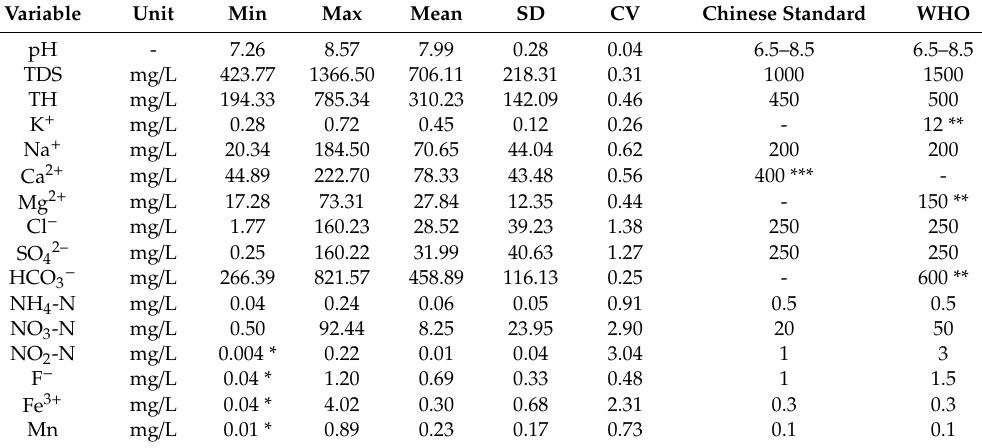
Table 2. Statistical analysis of the physicochemical parameters of shallow groundwater samples in the study area.